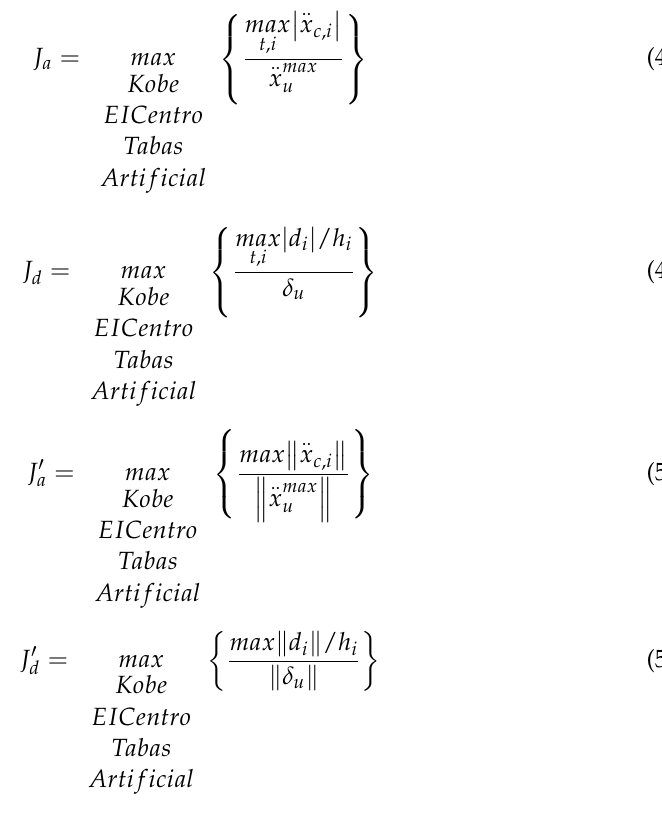
Table 5. Actuator placement in different